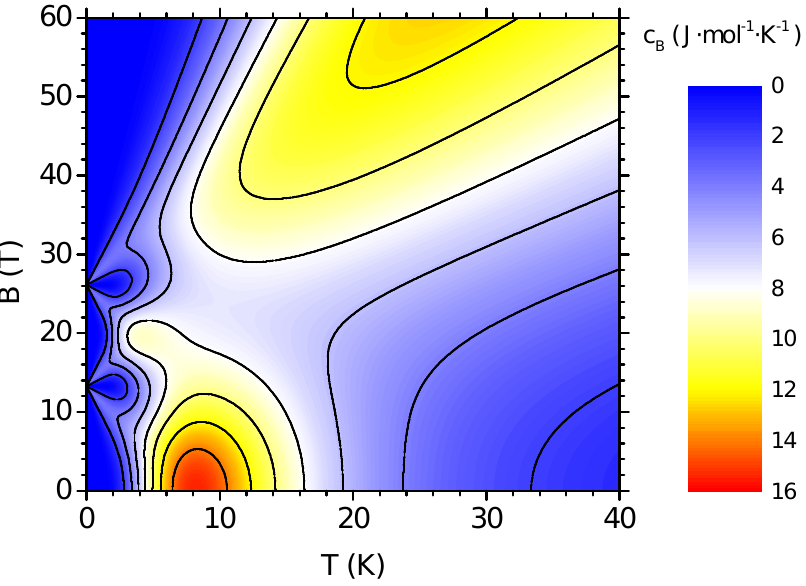
Figure 4. The density plot with contours showing the magnetic specific heat per mole as a function of the temperature and the external magnetic